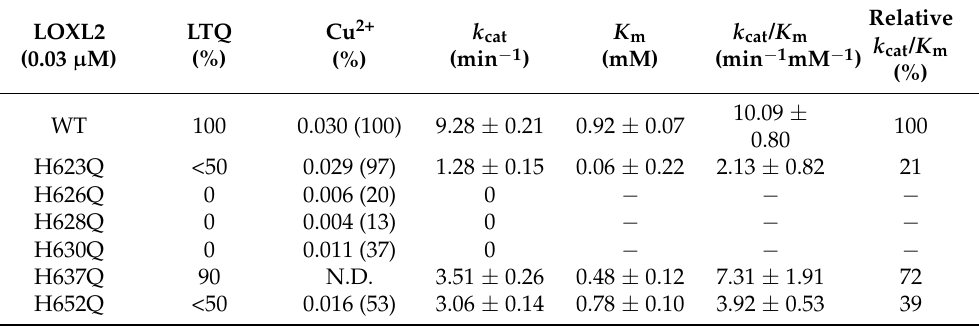
Table 3. Properties and kinetic parameters of LOXL2 in cadaverine oxidation.